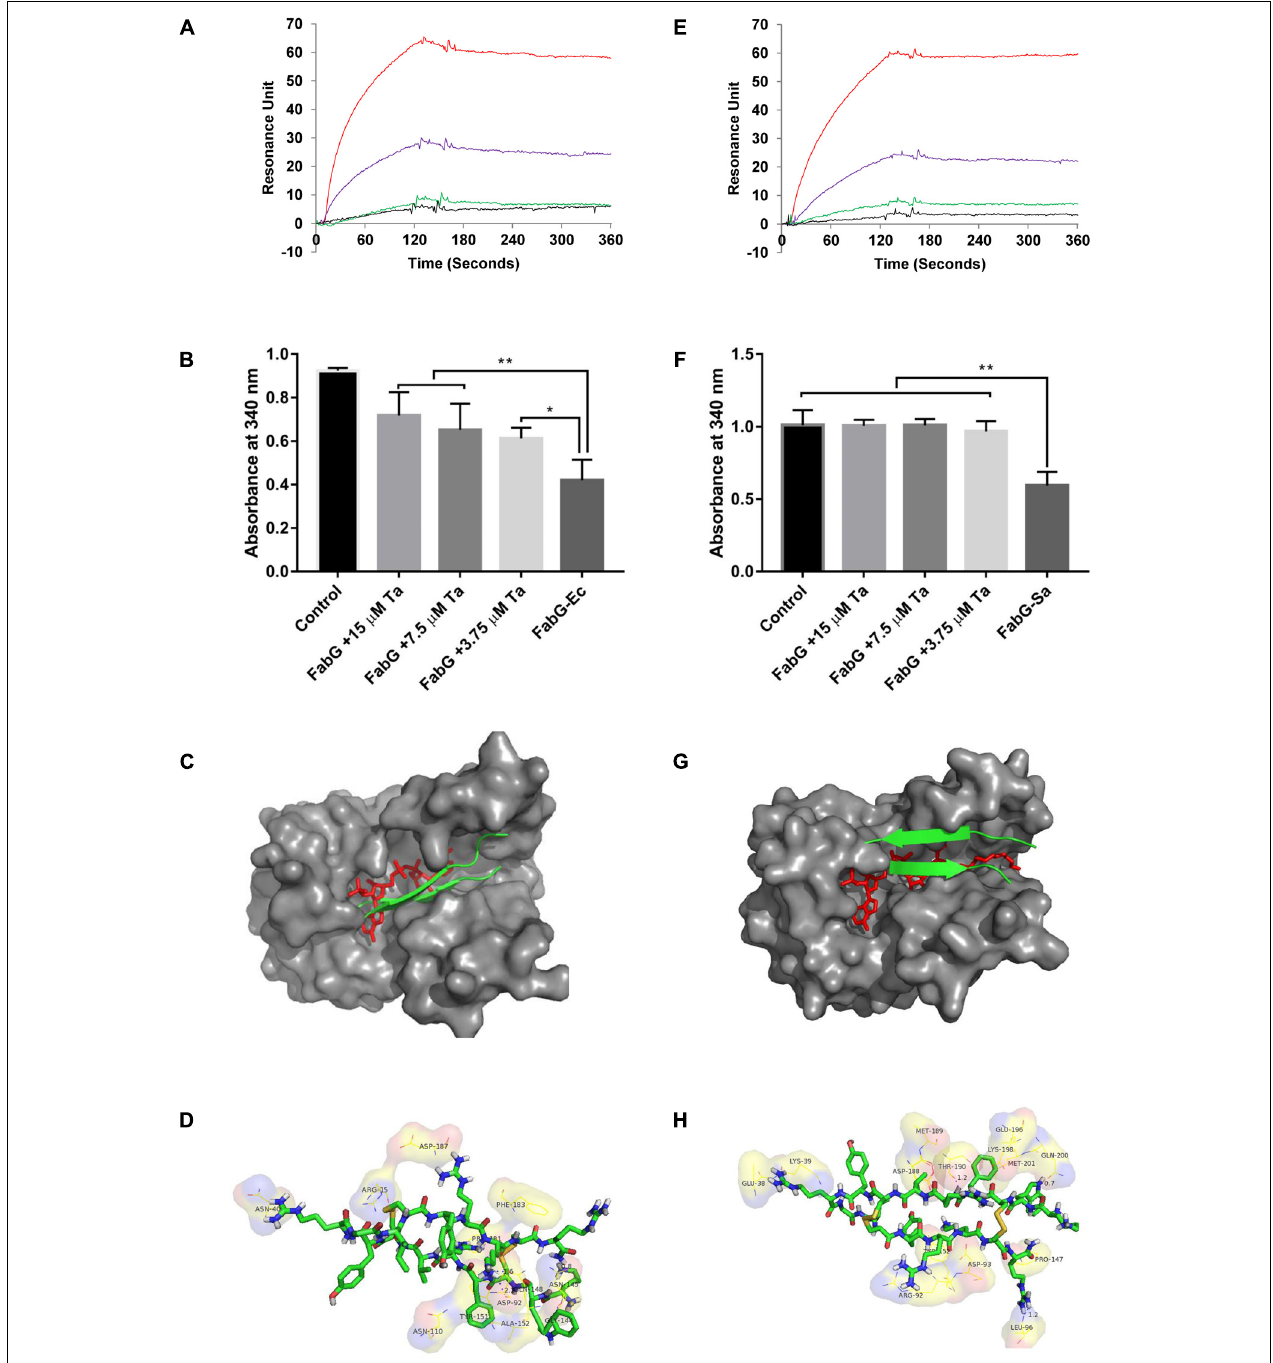
FIGURE 7 | Tachyplesin III binding with FabG inhibits its enzyme activities in vitro , probably by blocking the active site. Binding interactions between tachyplesin III and FabG from E. coli (A) or from S. aureus (E) were analyzed by surface plasmon resonance (SPR) with a Biocore 3000 (Biocore, Piscataway, NJ, United States). Black line: 1.25 µ g/mL FabG; green line: 2.5 µ g/mL FabG; purple line: 5 µ g/mL FabG; and red line: 10 µ g/mL FabG. The inhibitory activity of tachyplesin III on FabG from E. coli (B) or from S. aureus (F) was evaluated based on the remaining NADPH (which shows absorbance at 340 nm at ε 340 = 6.3 × 10 3 mol − 1 ) after FabG consumption for 5 min at room temperature. Tachyplesin was processed with Chemdraw 11.0 according to the structure of tachyplesin I (PDB code 2RTV) and then docked to the active site of FabG from E. coli (PDB code 1Q7B) or S. aureus (PDB code 3SJ7) with AutoDock4 using the default settings. Docking of tachyplesin III into E. coli is shown in (C) , docking details are shown in (D) . Docking of tachyplesin III into S. aureus is shown in (G) , docking details are shown in (H) . In (C,G) , tachyplesin III is shown in green, and NADPH is shown in red. Statistical significance was analyzed by one-way ANOVA followed by the Newman–Keuls multiple-comparisons test, ∗∗ p < 0.01, ∗ p <